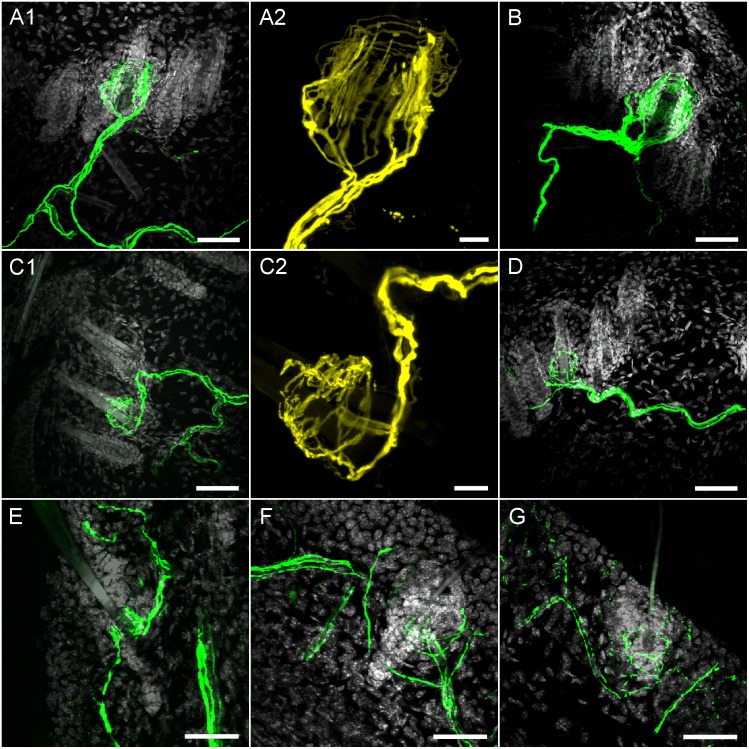
Confocal imaging of YFP expression in hairy skin nerve terminals.
A1, A2 and B, YFP-expressing longitudinal lanceolate endings innervating hair on dorsal skin. C1, C2 and D, YFP-expressing circumferential lanceolate endings innervating hair on dorsal skin. E, YFP-expressing longitudinal lanceolate ending innervating hair on ear skin. F and G, YFP-expressing circumferential lanceolate endings innervating hair on ear skin. A1, B, C1, D-G: YFP is shown in green and DAPI is shown in greyscale, scale bar represents 40 μm. A2 and C2: YFP is shown in yellow, scale bar represents 10 μm.